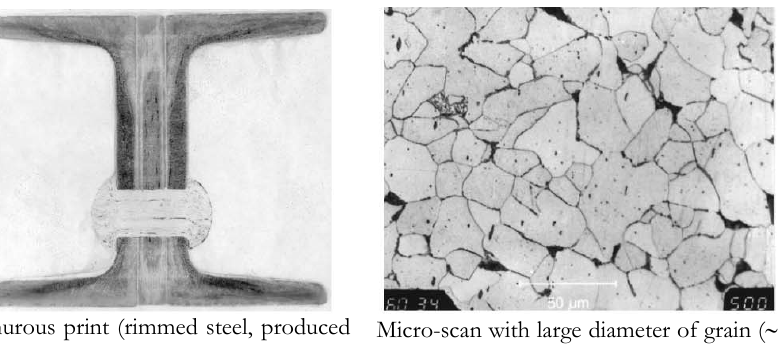
Figure 1: Characteristics of puddled iron [5].